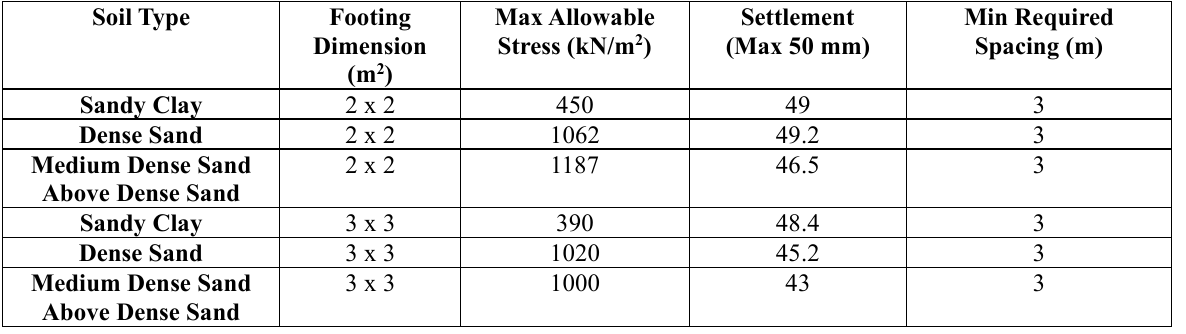
Required minimum spacing for sandy soil.